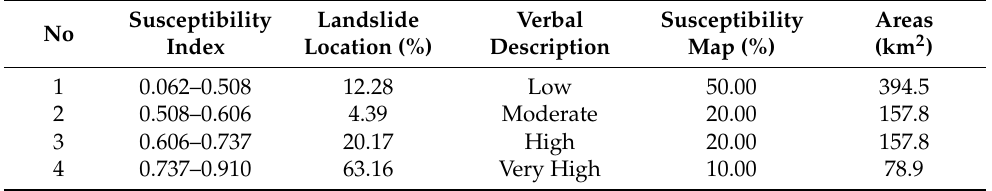
Table 5. Characteristics of the four susceptibility categories of the BBO-DE-StreeEns